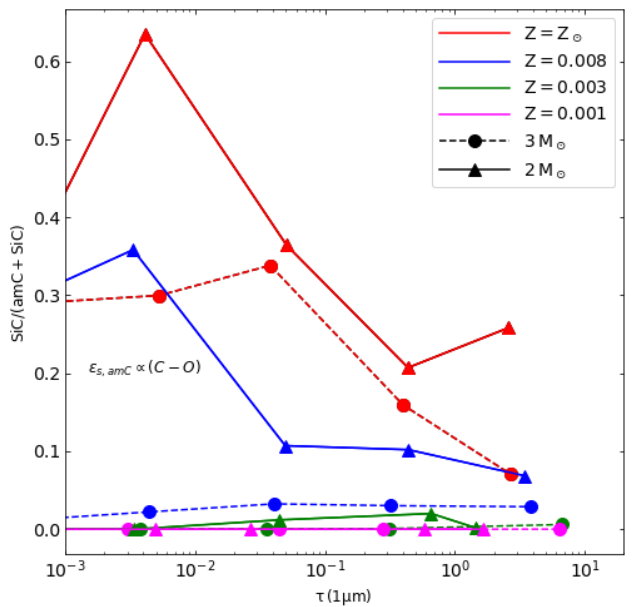
Figure 2. The mass ratio of SiC dust as a function of initial stellar mass and metallicity as indicated in the legend. The seed particle abundance for amC dust is assumed to be proportional to the carbon excess (see Table